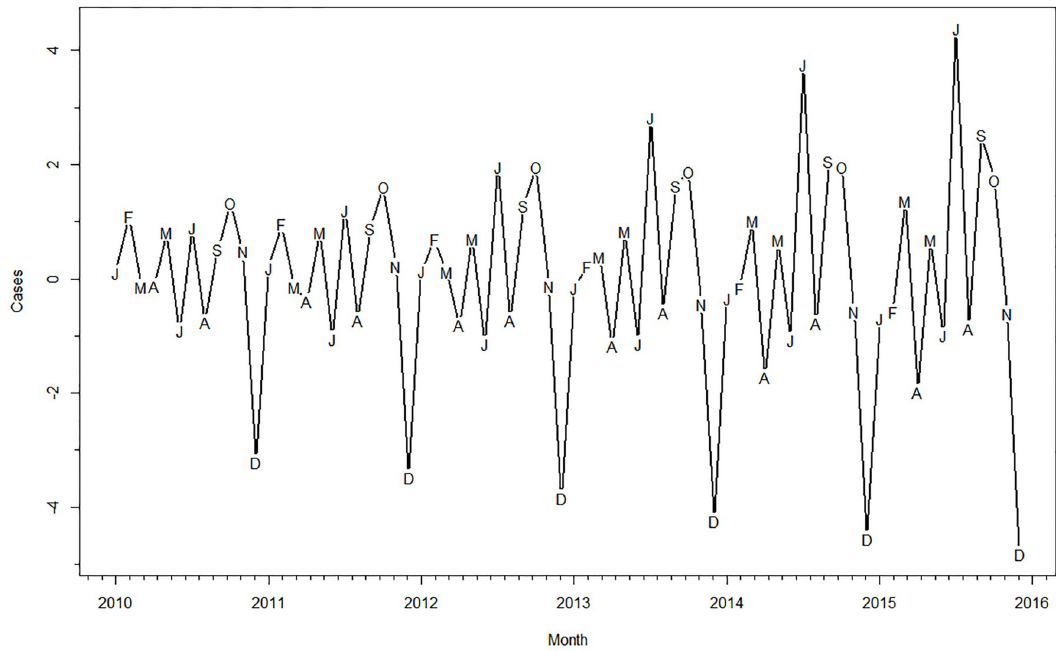
Fig 3. Seasonal component of pediatric TB cases, Kampala, Uganda, 2010–2015. Months indicated by letters.